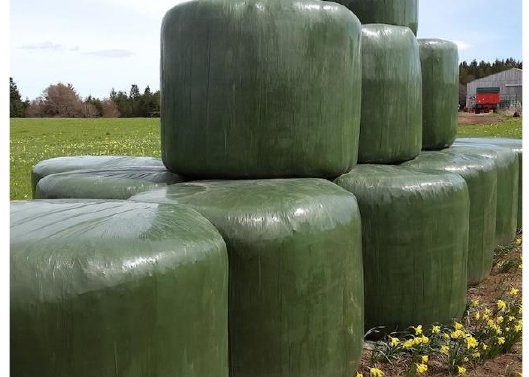
Figure 19. Wrapping stretch films. Reprinted from website [46].